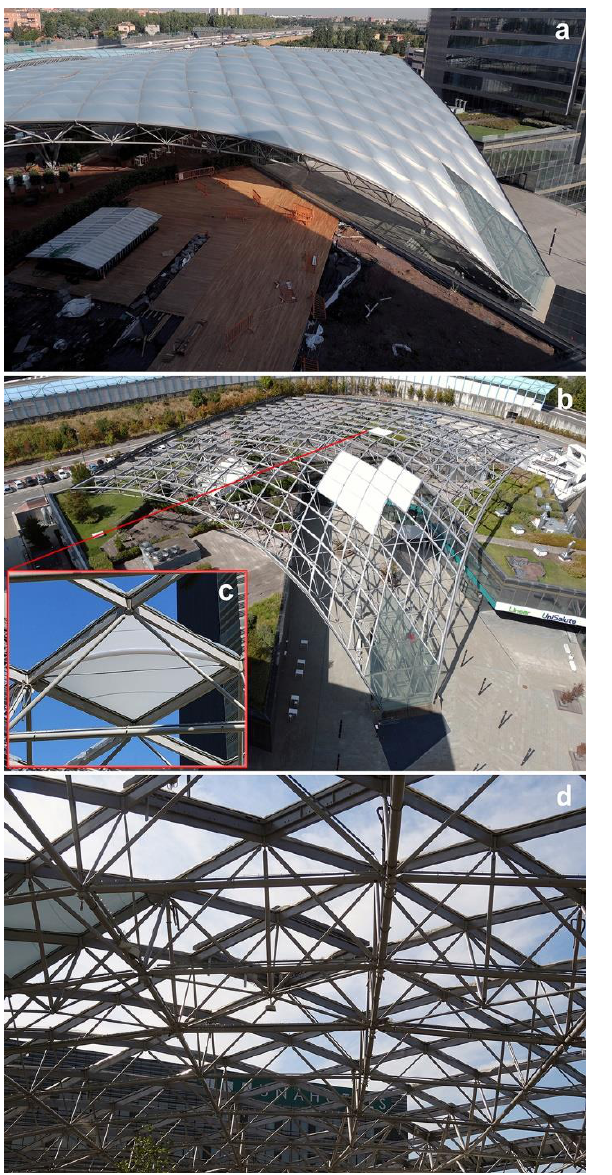
Figure 4: Diagonal extrados measures required for each mesh and detail of the